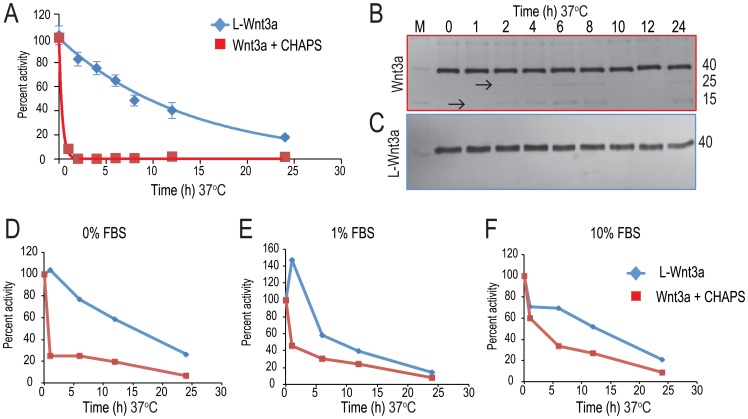
Liposomal packaging improves the stability of Wnt3a protein.(A) L-Wnt3a and Wnt3a (in CHAPS) was incubated at 37°C for 0, 1, 2, 4, 6, 8, 12 and 24 hours. These samples were used to treat LSL cells (see methods and figure 1). Wnt3a protein rapidly denatures and has a half-life of <1 h (red line). At the same temperature, L-Wnt3a resists denaturation and exhibits a half life of ∼10 h (blue line). (B) An immunoblot of these Wnt3a samples incubated at 37°C show smaller molecular weight degradation bands (arrows). (C) An immunoblot showing L-Wnt3a samples incubated at 37°C over the 24 h time course. Data are mean ±SEM from, or are representative of, at least three independent replicates. (D) At 37°C in the absence of serum Wnt3a protein rapidly loses activity (red line) whereas the L-Wnt3a retains activity and has a half-life of 10 h. (E) At 37°C when Wnt3a is incubated in the presence of 1% FBS (red line) loses activity less rapidly than in the absence of FBS and has an half life of 5 h. L-Wnt3a shows similar rate of loss in activity in the presence of 1% FBS as in the absence of FBS. (F) In the presence of 10% FBS, Wnt3a has an improved half life of 10 h (red line) whereas L-Wnt3a (blue line) shows a similar half life in the presence and absence of FBS.